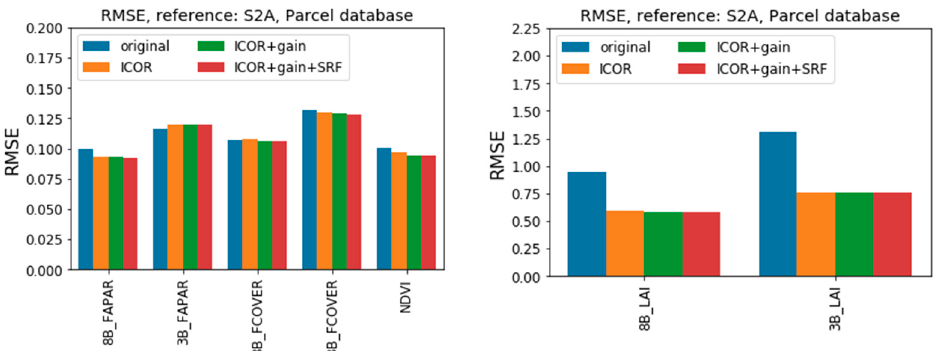
Figure 9. Same as Figure 7 but for the parcel database.